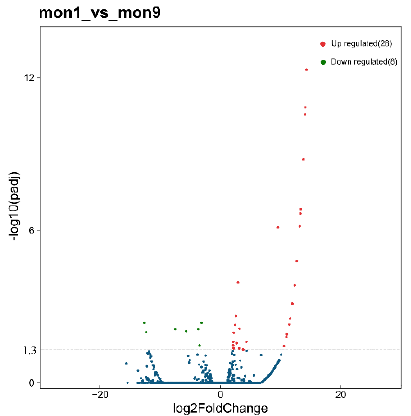
Figure 3. Analysis and validation of differentially expressed lncRNAs. The volcano plot analysis of all lncRNAs in 1-month-old vs. 9-month-old comparison. The red points showed the upregulated lncRNAs, the green points showed the downregulated lncRNAs, and the blue points showed the equally expressed lncRNAs.